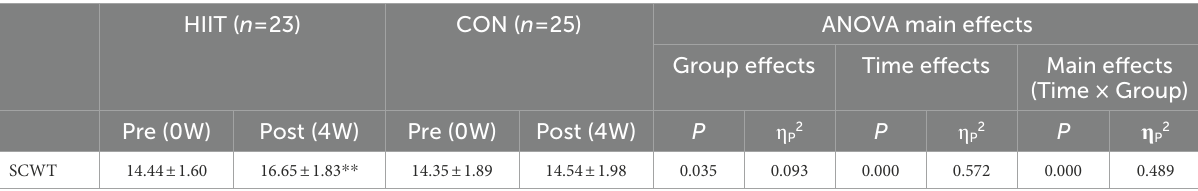
TABLE 6 Executive function before and after the four-week study program.